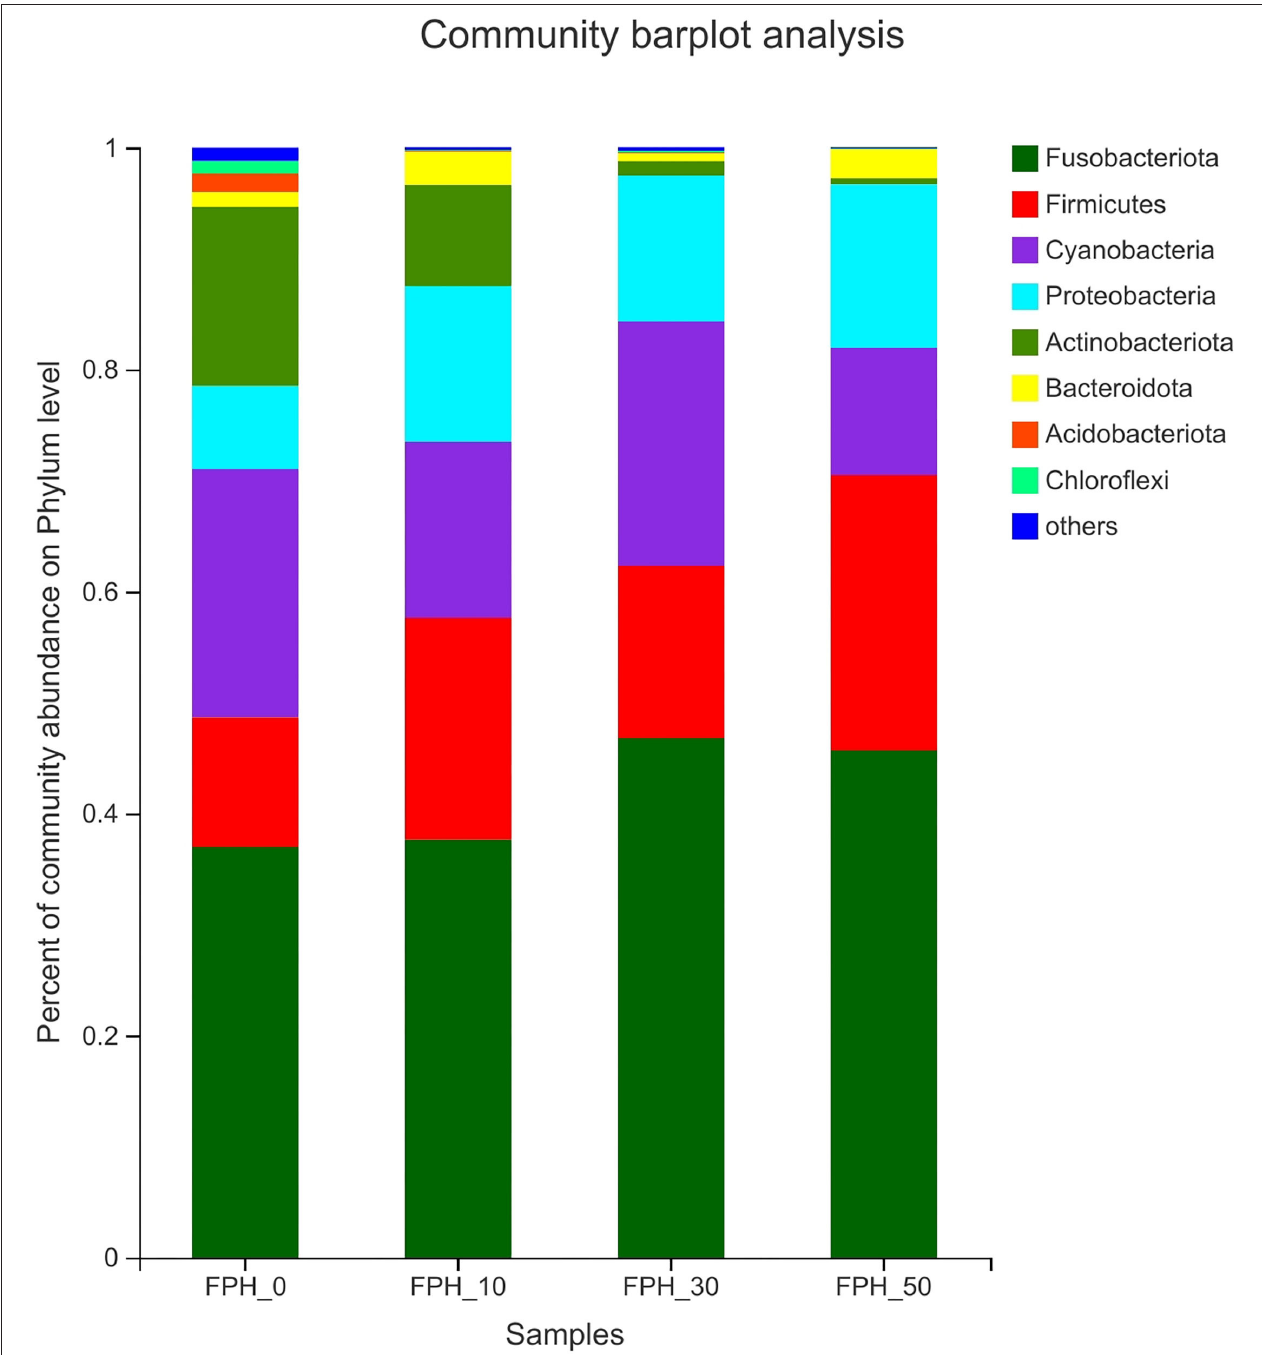
FIGURE 6 | Histogram of relative abundance of intestinal microflora of largemouth bass ( Micropterus salmoides ) fed the diets containing different supplementation levels of fish protein hydrolysate (FPH) at the phylum level.